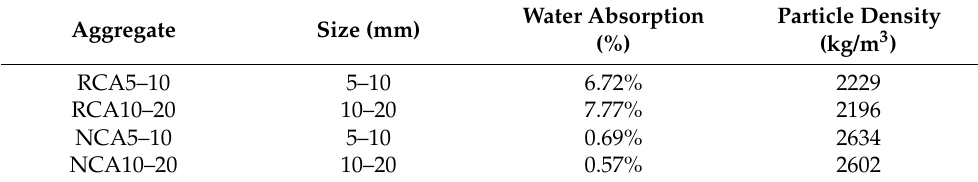
Table 1. Water absorption and particle density of coarse